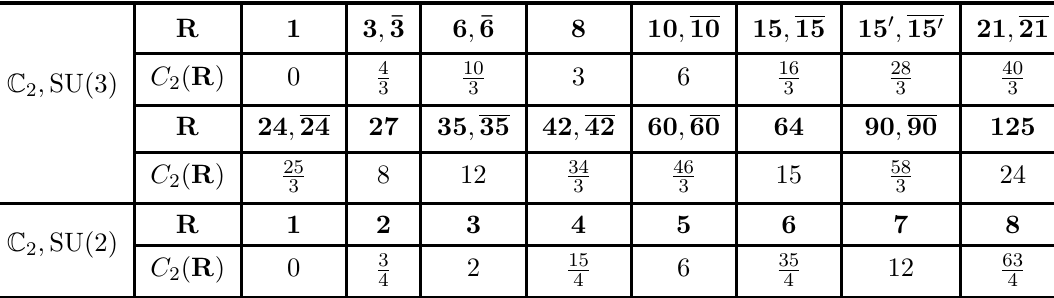
Table 33 . The eigenvalues of C 2 for commonly used representations of SU(3) and SU(2)